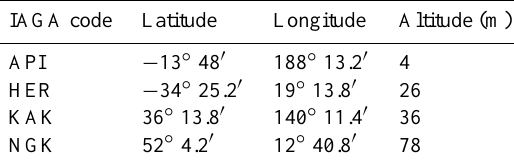
Fig. 1. Annual (upper) and monthly (lower) mean series of X, Y, Z components and their numerical derivatives (differences of the sequential values). Table 1. The geomagnetic observatories that have been chosen as representatives for